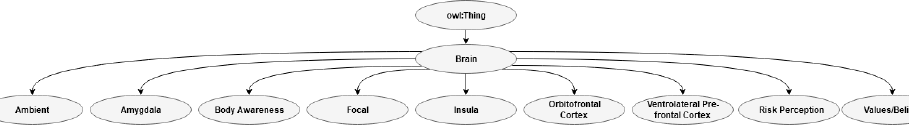
Figure 5. Class brain